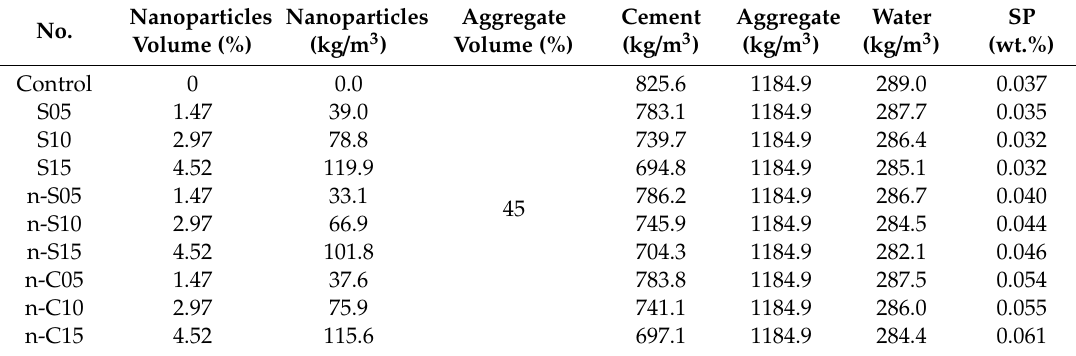
Table 2. Mix design and final proportions.